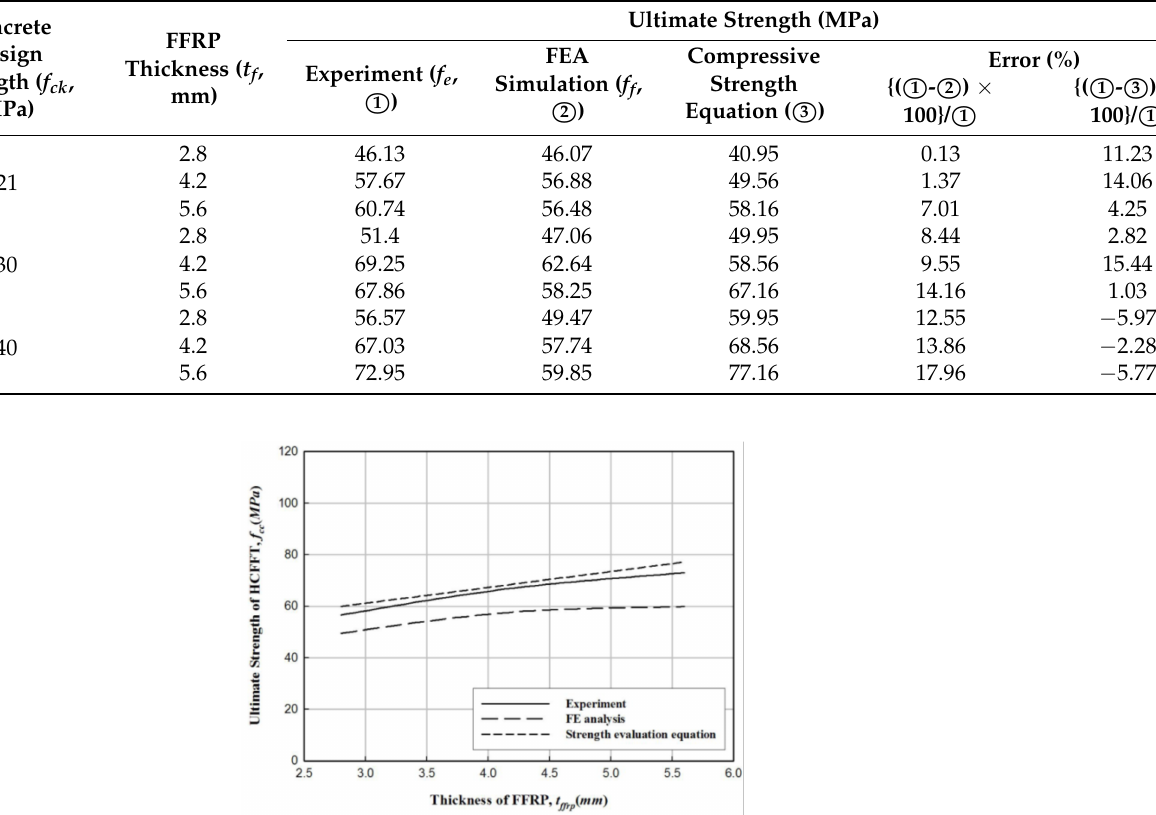
Table 11. Comparative results of the hybrid − CFFT.